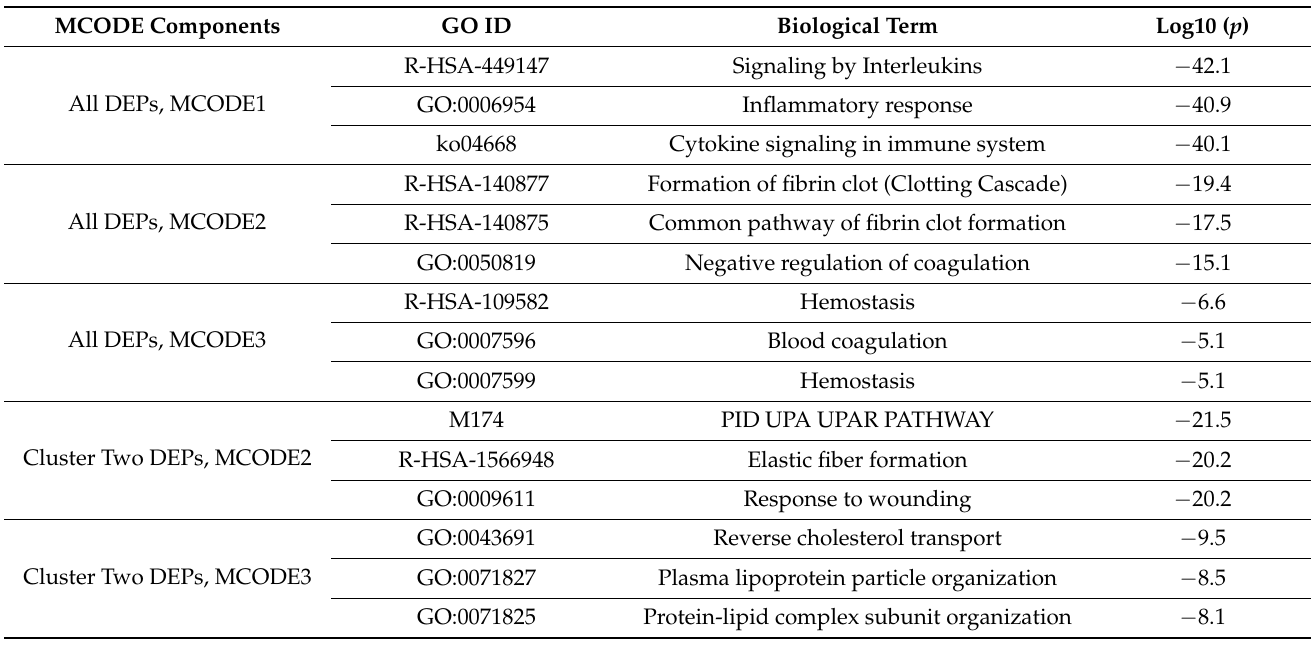
Table 1. Results of Molecular Complex Detection (MCODE) analysis performed on the differently expressed proteins (DEPs) of death due to ischemic stroke.